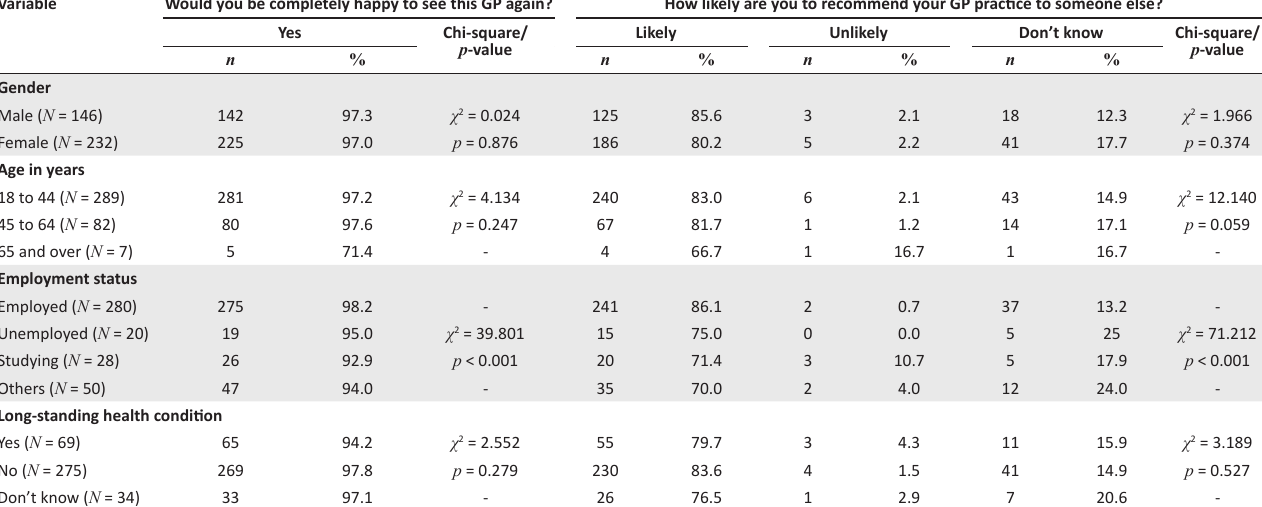
TABLE 5: Relationship between socio-demographics and overall patient satisfaction with quality of service delivery. Variable Would you be completely happy to see this GP